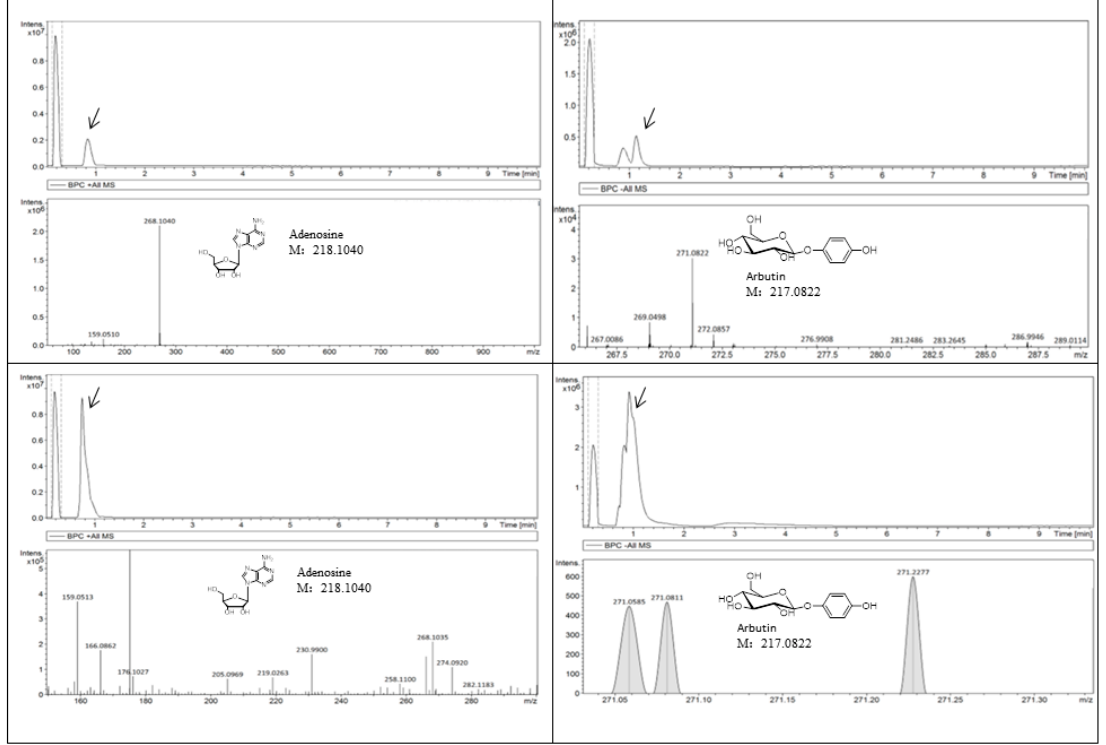
Figure 6. HPLC-MS fingerprint of the yam, adenosine and arbutin. Adenosine and arbutin were verified as genuine resveratrol tetramers in the Chinese yam.